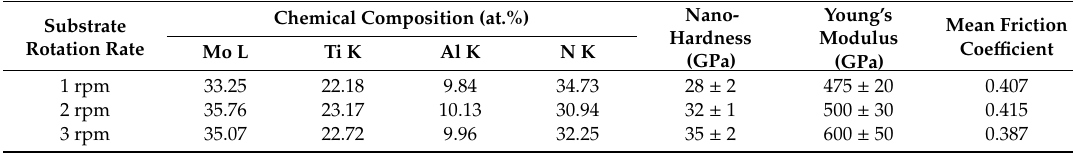
Table 2. Chemical composition, hardness, and friction coefficient of Mo-Ti-Al-N coatings prepared at various substrate rotation rates